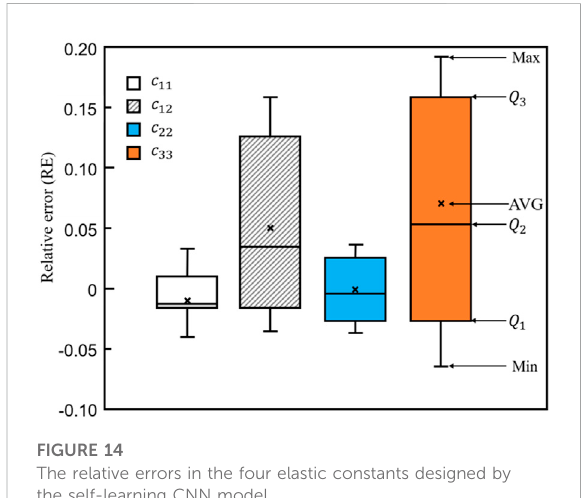
FIGURE 14 The relative errors in the four elastic constants designed by the self-learning CNN